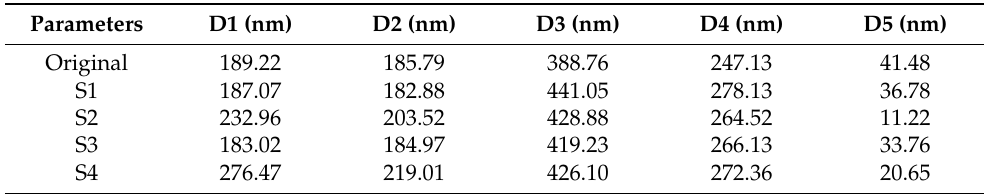
Table 2. The structures obtained by NN-PSO for AR coating in Figure 5.